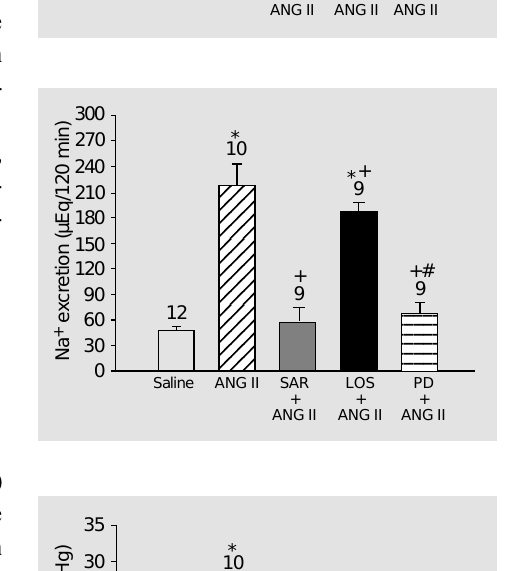
Figure 5. Effect of pretreatment with [Sar 1 , Ala 8 ] ANG II (SAR, 40 nmol), losartan (LOS, 40 nmol), and PD 123319 (PD, 40 nmol) into the paraventricular nucleus on urine excretion induced by injection of ANG II (10 nmol) into the medial septal area. Data are reported as means ± SEM. The number of animals is indicated at the top of each column. * P<0.05 compared with saline (control); + P<0.05 compared with ANG II; # P<0.05 compared with losartan (ANOVA).